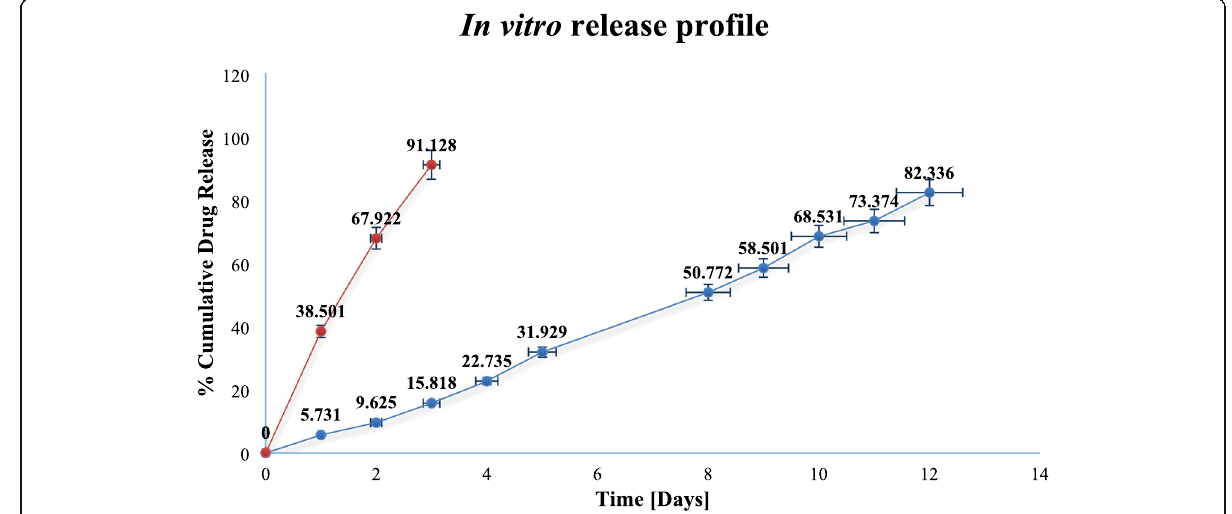
Fig. 10 Cumulative drug release profile of LB solution- and LB-NP-loaded contact